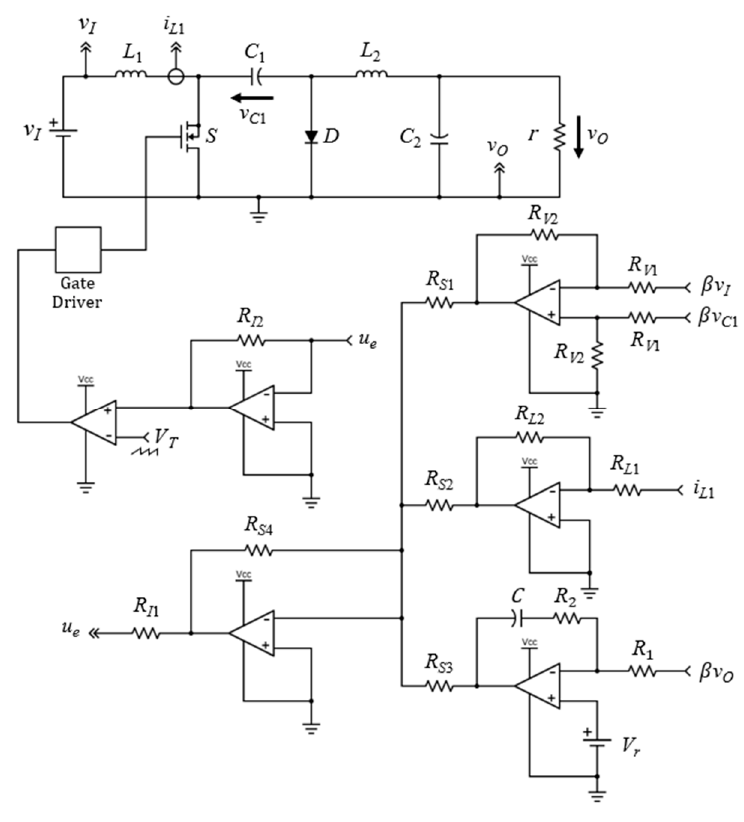
Figure 4. Schematic of proposed control circuit of the PWM DC-DC Cuk converter.